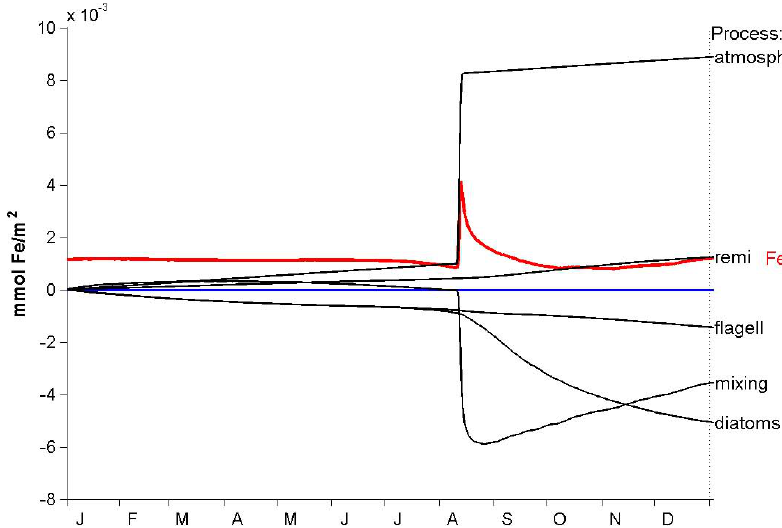
Fig. 10. Temporal cumulative iron budget (0–10m) at Papa with iron fertilisation in August 2008. “Fe”: iron amount, and the temporal cumulative fluxes “mixing”: vertical mixing; “diatoms”: uptake by diatoms; “flagell”: uptake by non-diatoms; “atmosph”: atmospheric input due to dust deposition and ash deposition; “remi”: pelagic